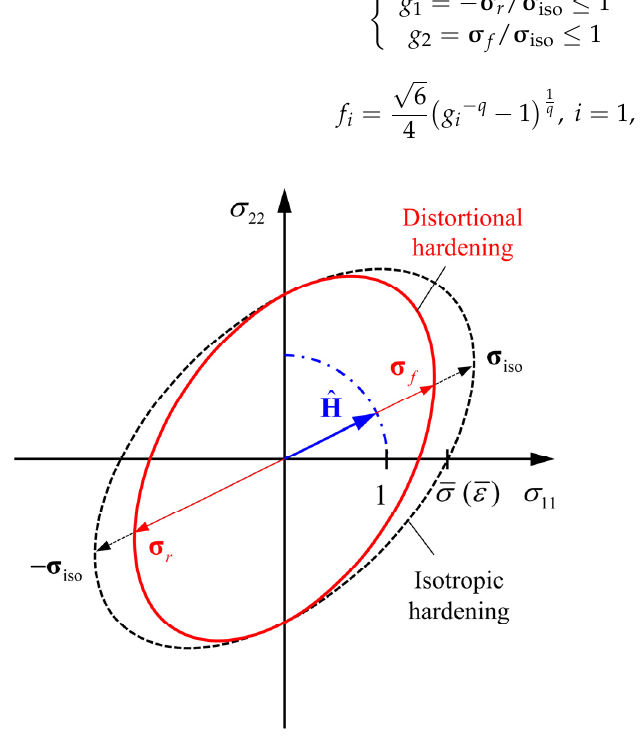
Figure 2. Schematic diagram of yield loci in σ 11 − σ 22 plane with f 1 > 0, f 2 > 0 and F L =